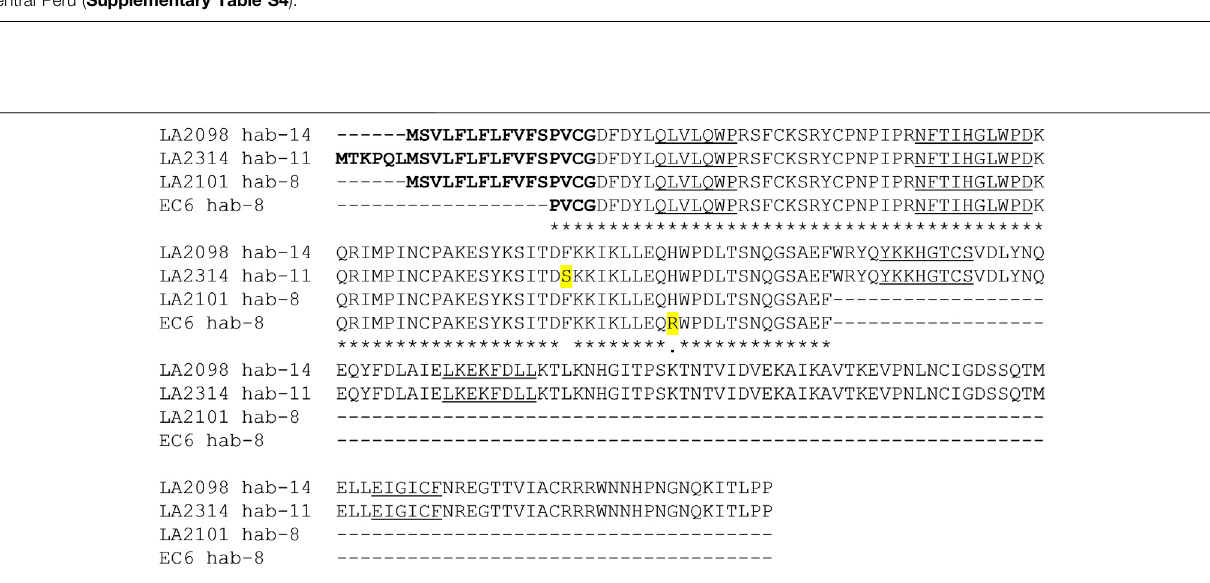
Frontiers in Genetics |